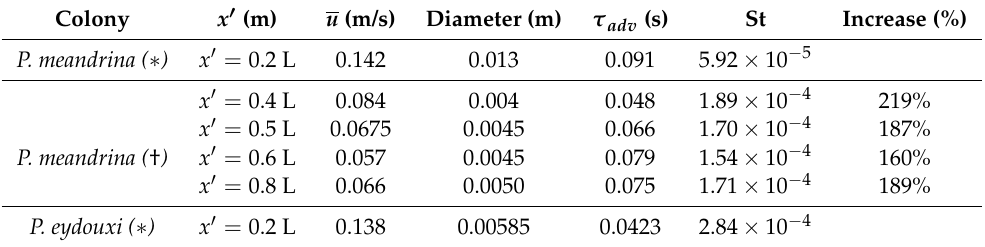
Figure 8. The Stanton number calculated in the interior of the P. meandrina colony based on the mean flow magnitude and advection time scale at Reynolds number 15,000. Here, the advection time scale was calculated based one the mean vortex diameter at different sections of P. meandrina perpendicular to the flow direction, and the mean velocity value in those sections. Table 2. Stanton number calculated along the length of the P. meandrina colony in the flow direction using two different methods (top and middle values) and the Stanton number calculated along the length of the P. eydouxi colony using the first method only (bottom values). Key: * The mean branch diameter was used as a length scale to calculate these values. † The mean diameter of the vortices was used as a length scale to calculate these